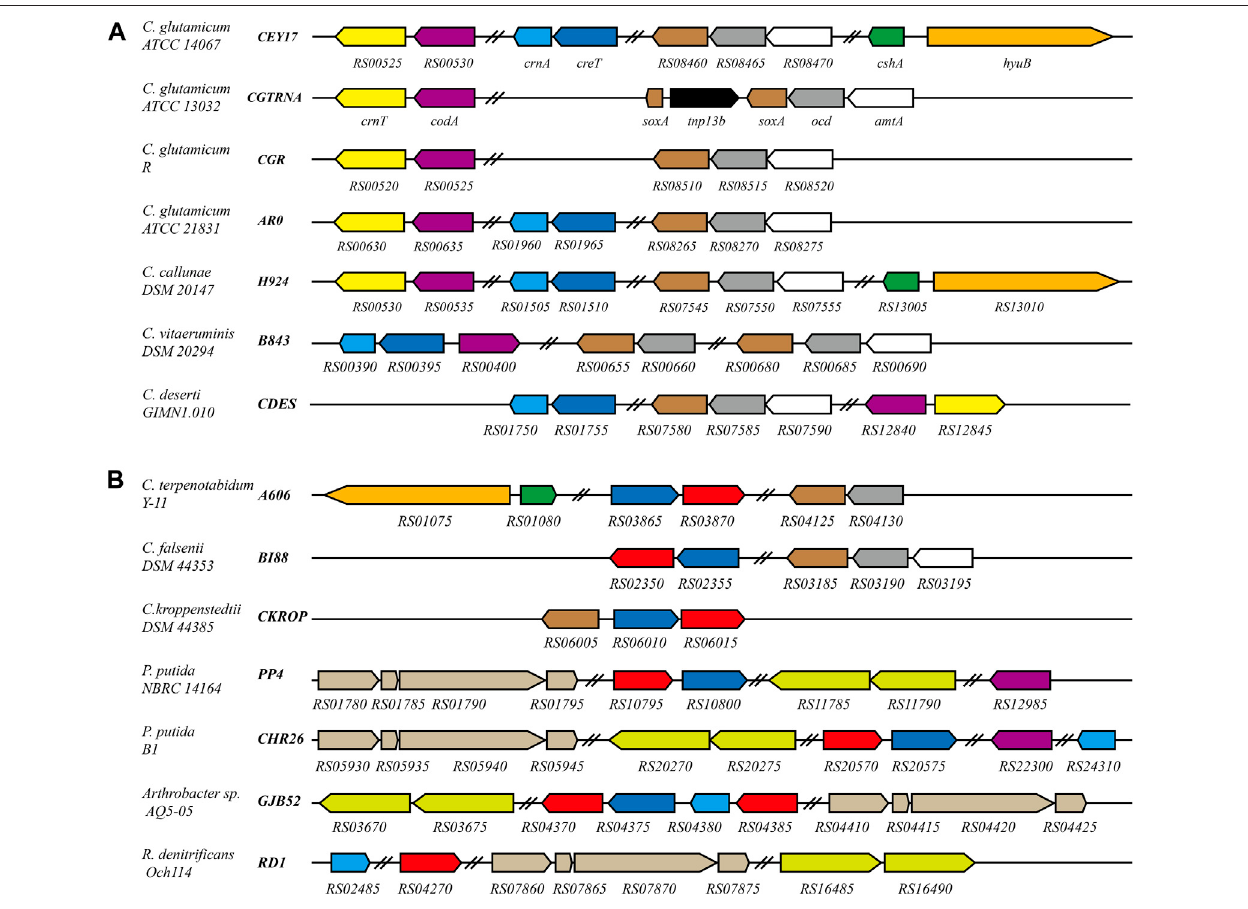
FIGURE 6 | Schematic representation of the creatine and creatinine degradation gene cluster in C. glutamicum and related bacteria. Black bold italics indicate locus_tagpre fi x;homologousgenesarepresented inthesamecolor.Redrepresentsthegeneencodingcreatinase(CreA).Navybluerepresentsthegeneencodingthe protein related to creatine transport. In C. glutamicum ATCC 13032, sox A is interrupted by tnp13b. In P. putida NBRC 14164, P. putida B1, Arthrobacter sp. AQ5-05 and R.denitri fi cans Och114,sarcosineoxidaseisaheterotetrameric;hydantoinaseisaheterodimer.Doubleslashesindicatethatthegenesarenotcontinuous. (A) The genes related to creatine and creatinine degradation are regulated by AmtR in these strains. (B) Homologs of AmtR are not present in these